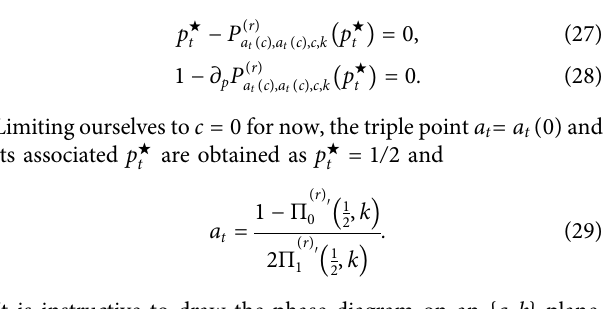
election. Figure 5 and Figure 6 show a series of cases illustrating the above two scenarios.